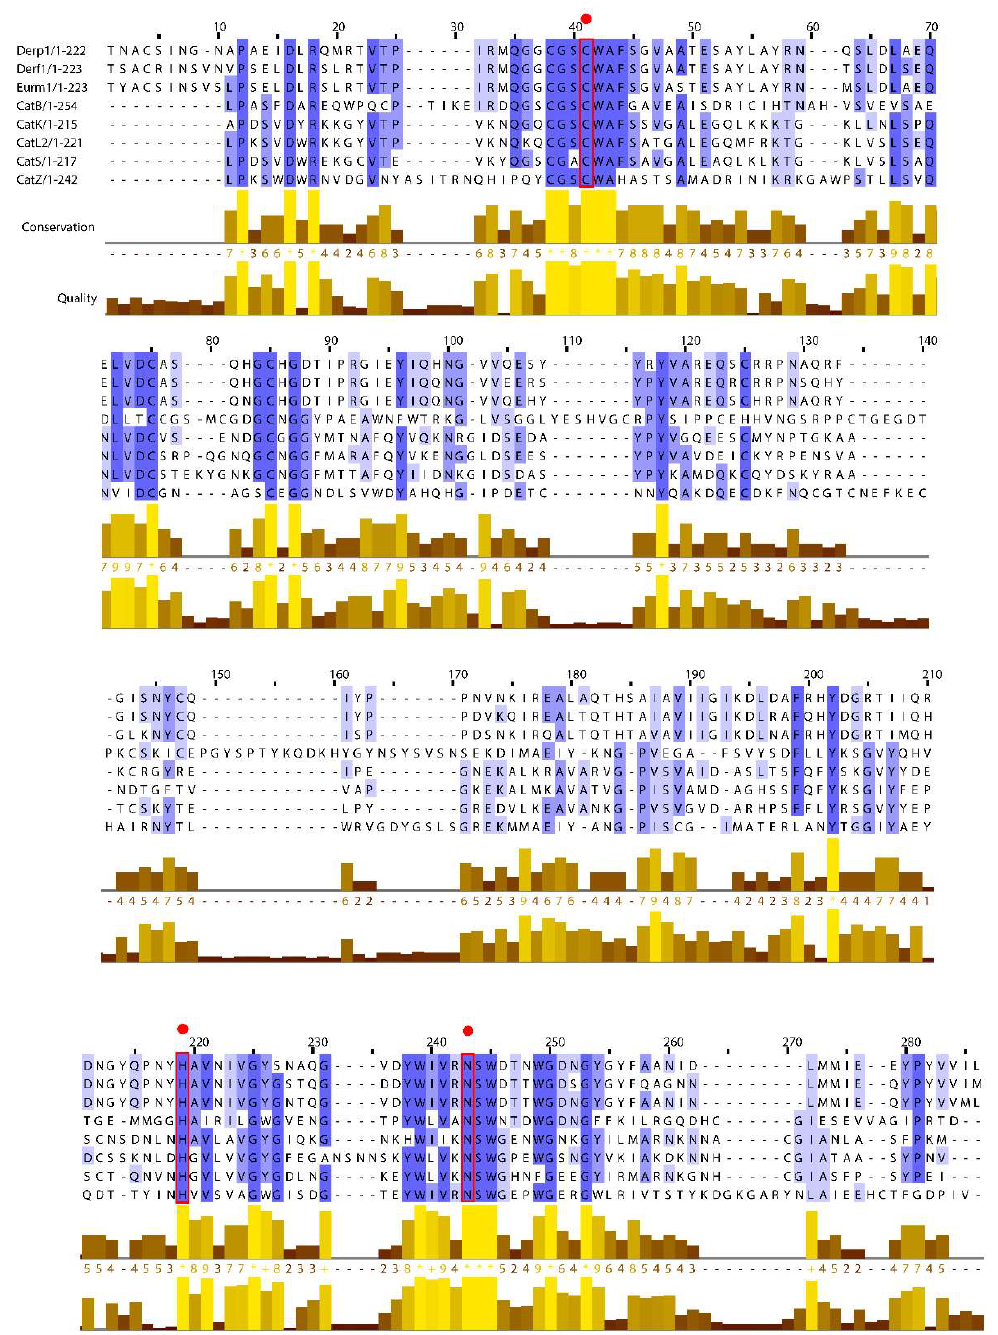
Figure 2. Multiple sequence alignments for the mature forms of HDM group 1 allergens from Dermatophagoides and Euroglyphus species with cathepsin family representatives (cat B, K, L2, S, and Z). Graphical representations of conservation and quality were created using Clustal Omega and Jalview. Threshold for conservation was set at 30%. Red rectangles and circles denote catalytic triad residues.